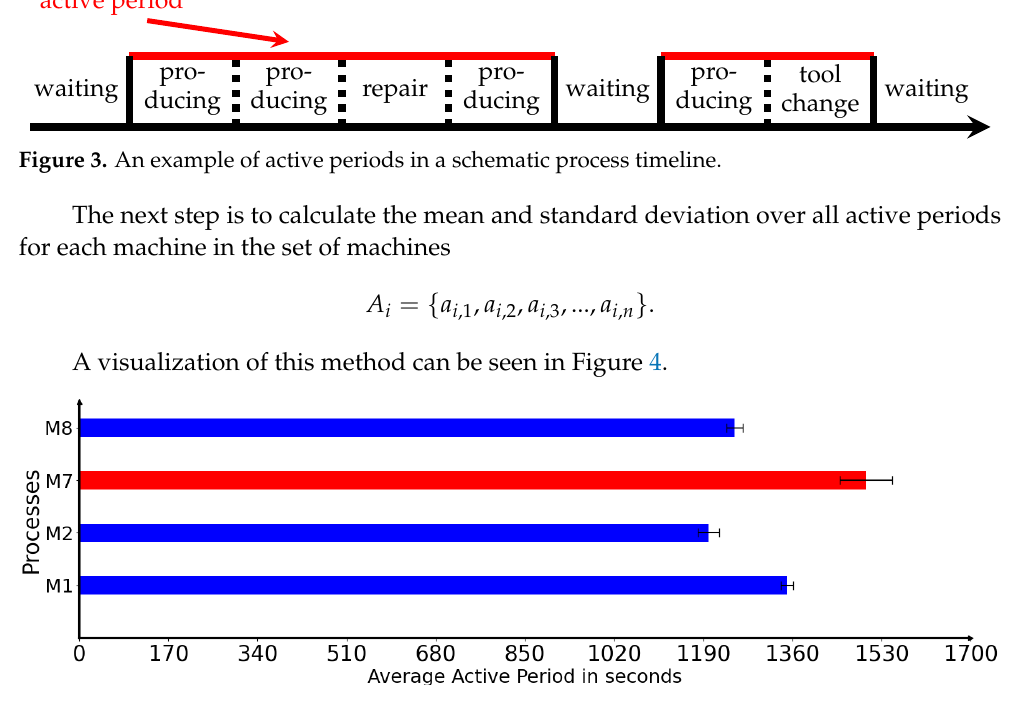
Figure 4. An example on the Average Active Period Method. M1, M2, M7 and M8 refers to different machines in the production process. We selected this subset of machines (sub-processes), because it is appropriate for the visualization of the Active Period Method. M7 (red) is the sub-process with the longest average active